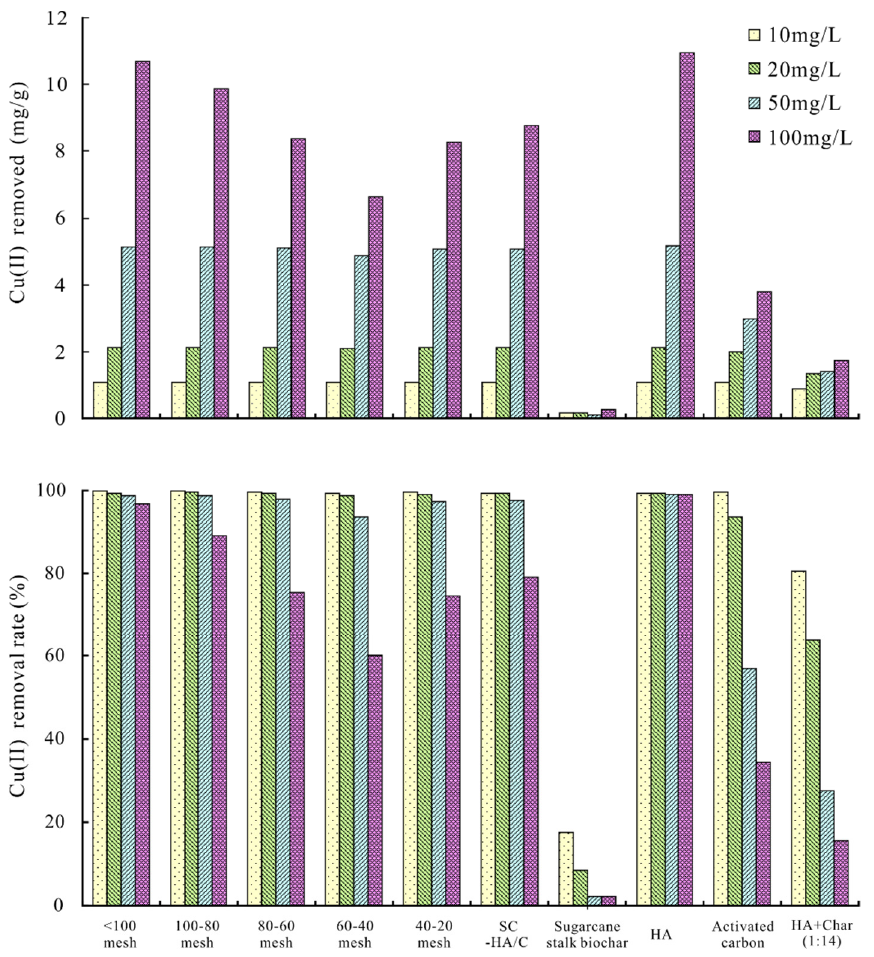
Figure 10. Removal of Cu (II) by SC–HA/C of various particle sizes, sugarcane stalk biochar, synthesized hydroxylapatite, commercial activated carbon, and hydroxylapatite–biochar mixture (25 °C; initial pH 5.0; SC–HA/C dose 0.5g/50 mL).